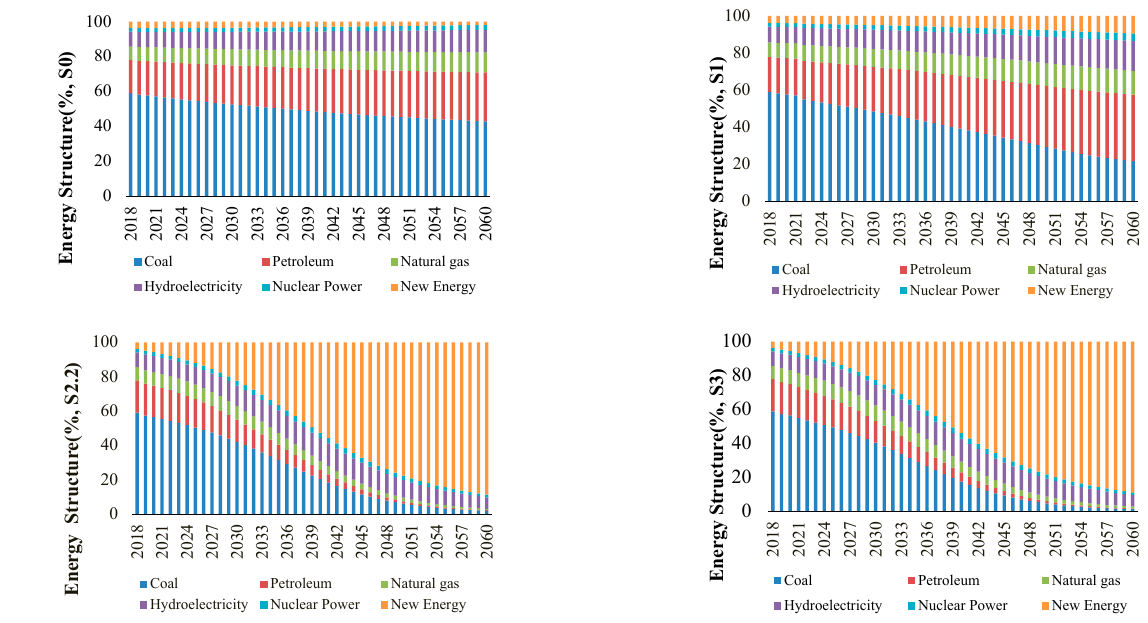
Figure 6. Energy structure transformation based on four scenarios in China.